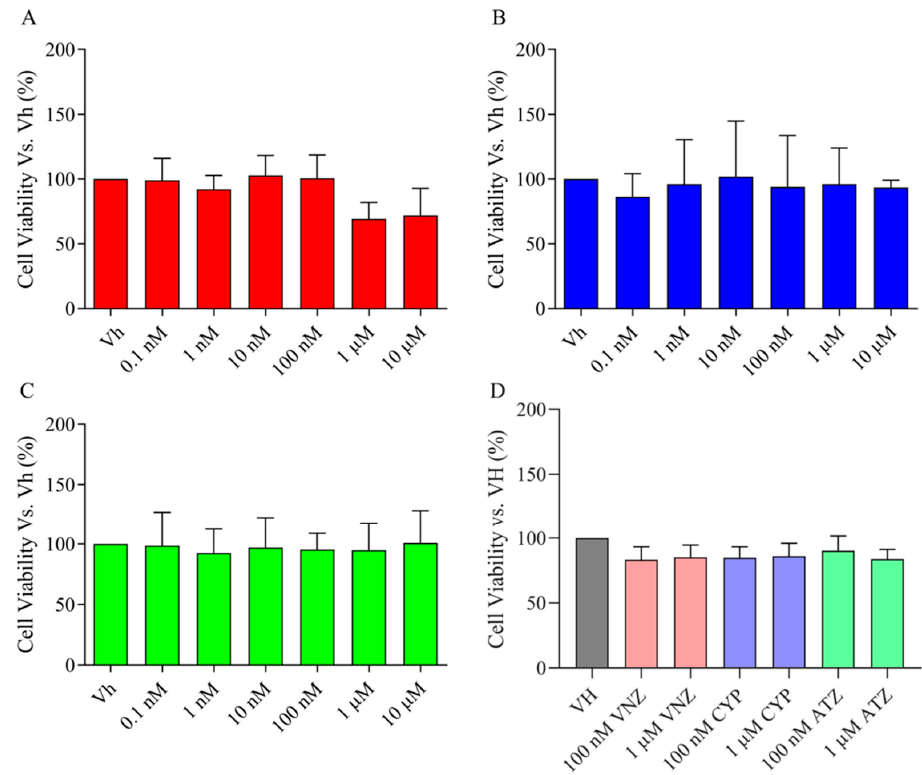
Figure 2. Neuronal viability in undifferentiated and differentiated SH-SY5Y after the treatment with EDCs. Cells were used as undifferentiated ( A – C ) or differentiated with retinoic acid ( D ) and treated for 48 h with EDCs. Undifferentiated SH-SY5Y cells were treated with VNZ ( A ), CYP ( B ), or ATZ ( C ) [0.1 nM–10 μ M] and cell viability was evaluated by the reduction in MTT to the insoluble formazan. Differentiated SH-SY5Y cells were treated with EDCs 100 nM or 1 μ M ( D ). Cell viability was evaluated using the AlamarBlue HSTM test by the conversion of resazurin to resorufin. Data are expressed as fold increases of the percentage of cell viability versus the vehicle group and reported as mean ± SD of three independent experiments (One-way ANOVA, post hoc test Dunnet).